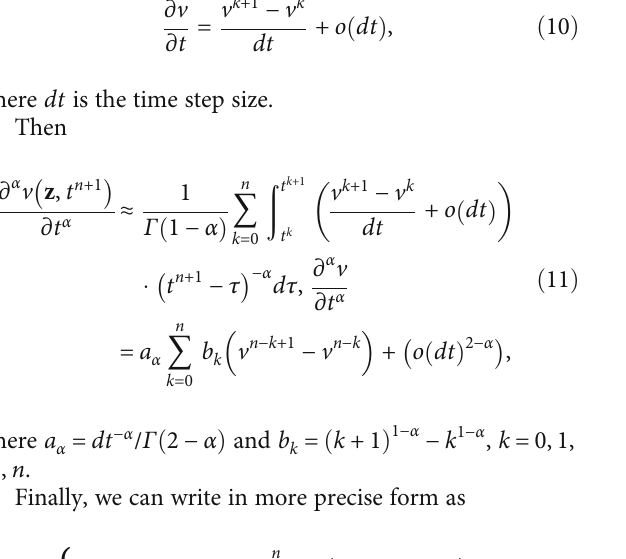
Figure 1: Comparison of E ∞ of IS and CNS for the Problem